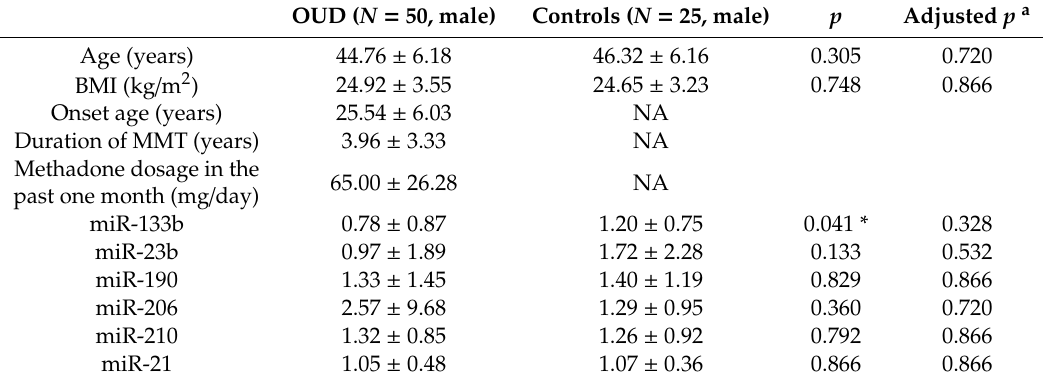
Table 1. Characteristics and clinical data of patients with opioid use disorder and healthy controls in the